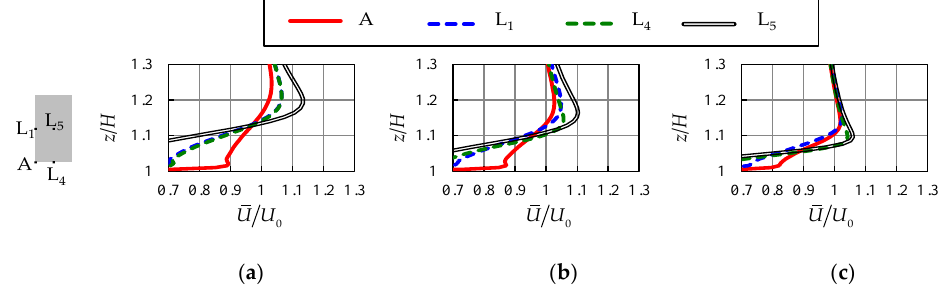
Figure 11. Vertical profiles of horizontal wind velocity ratios at representative locations on the roof, in the case of no prevailing wind direction. ( a ) HAR = 1.00; ( b ) HAR = 0.50; ( c ) HAR = 0.25. Energies 2016 , 9 , 907